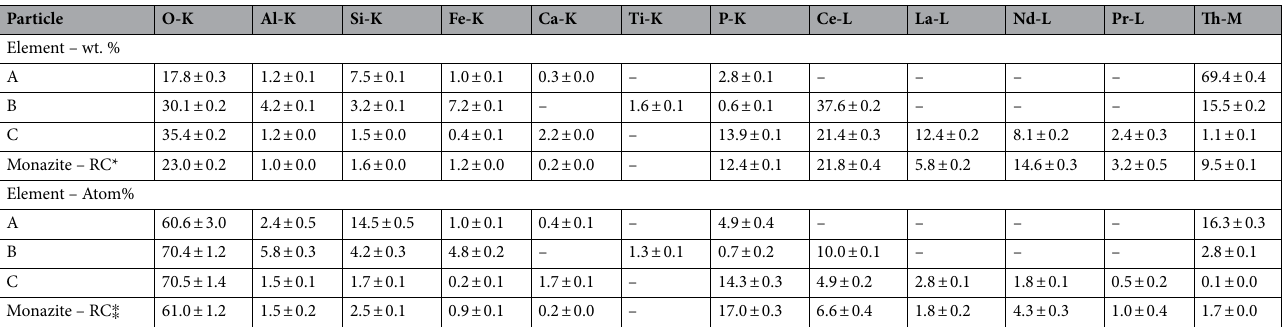
Table 2. Weight and atom concentration of each element (relative %) obtained by SEM–EDX for the isolated selected particles (i.e., particle A – Th-silicate, particle B – Th-Ce-oxide, particle C – Th-REE-phosphate) and the monazite RC. *Contains Sm-L, Gd-L, U-M: 3.5, 1.6, 0.6 wt.% and ⁑ 1.0, 0.4, and 0.1 atom%,